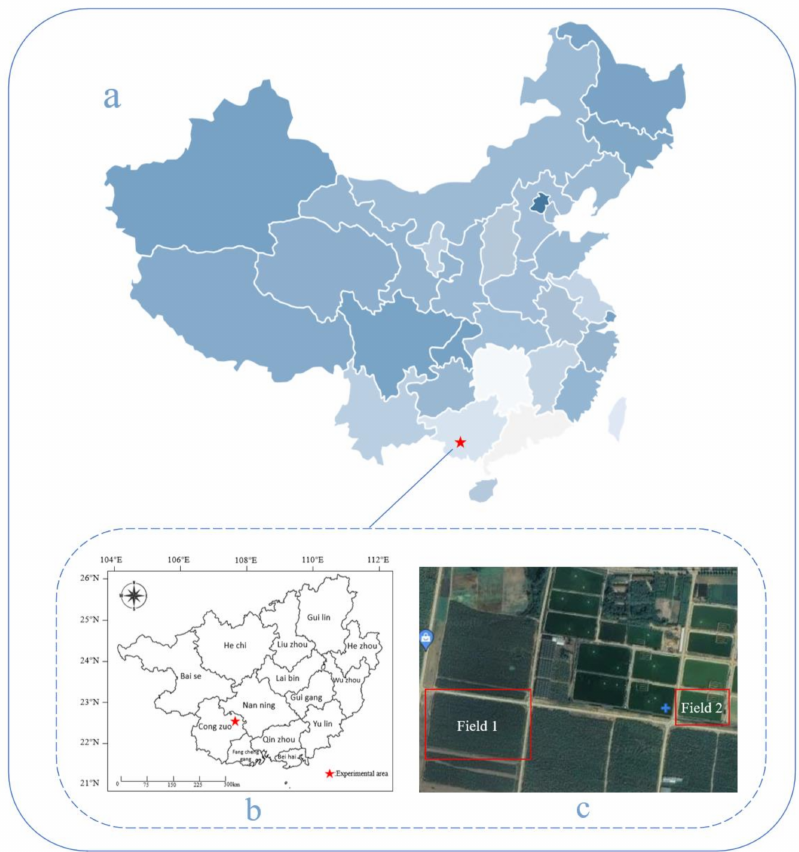
Figure 1. The geographic information of the experimental sugarcane fields: ( a ) location of the study area in China; ( b ) geographical location of the study area; ( c ) satellite image of the study fields (source: google satellite map).